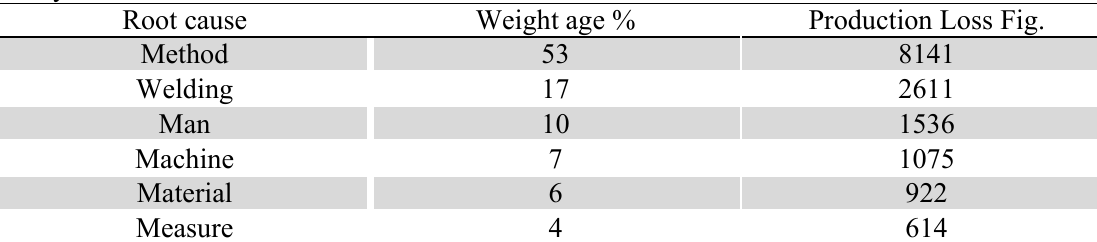
Analysis of root cause